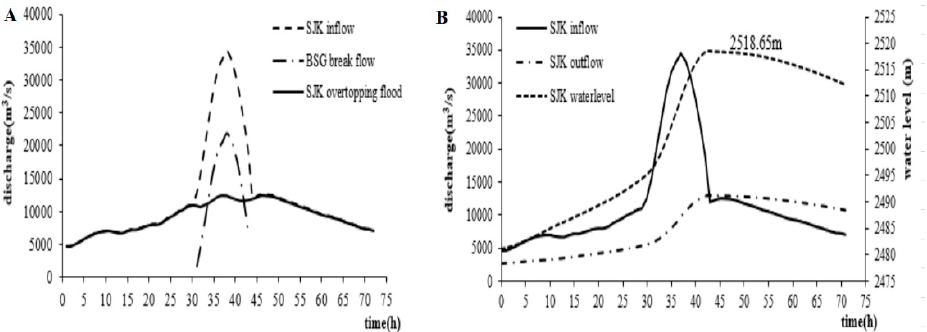
Figure 11. ( A ) The BSG break flood encounters SJK overtopping flood; ( B ) the regulated flood progress of SJK.